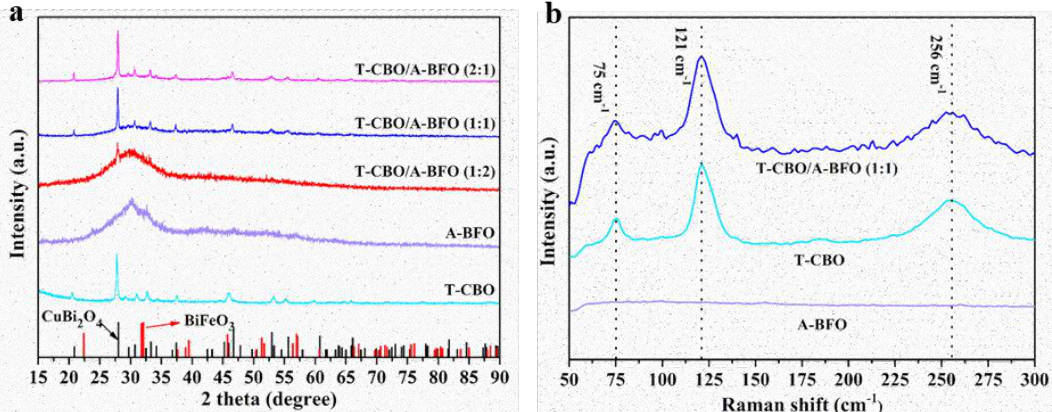
Figure 1. ( a ) XRD patterns of the T-CBO, A-BFO, and T-CBO/A-BFO composites with different composite ratios; ( b ) XRD patterns of the CuBi 2 O 4 , BiFeO 3 , and CuBi 2 O 4 /BiFeO 3 composite photocatalyst with different composite ratios and after calcination.